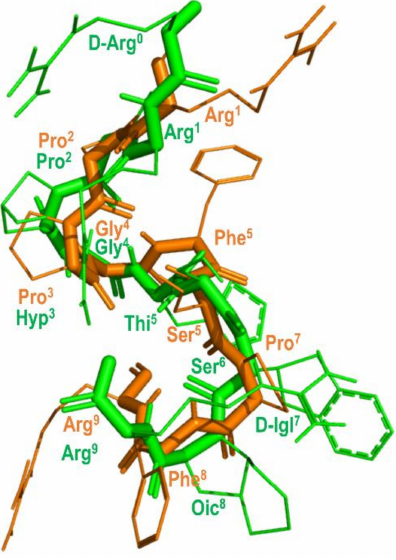
Figure 8. Overlay of the 3D structure of BK bound to the B2 receptor (in orange) (pdb id: 6f3v) and the structure of B-9340 in aqueous solution (in green) (pdb id: